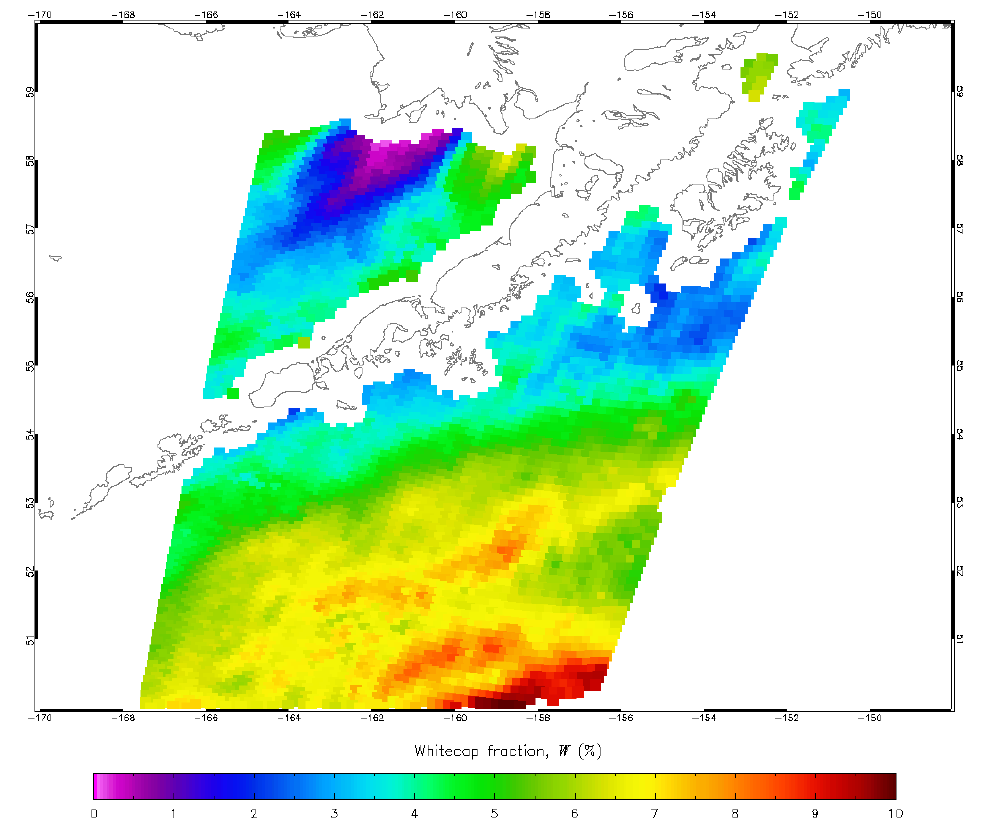
Figure 1. WindSat whitecap retrievals on 9 February